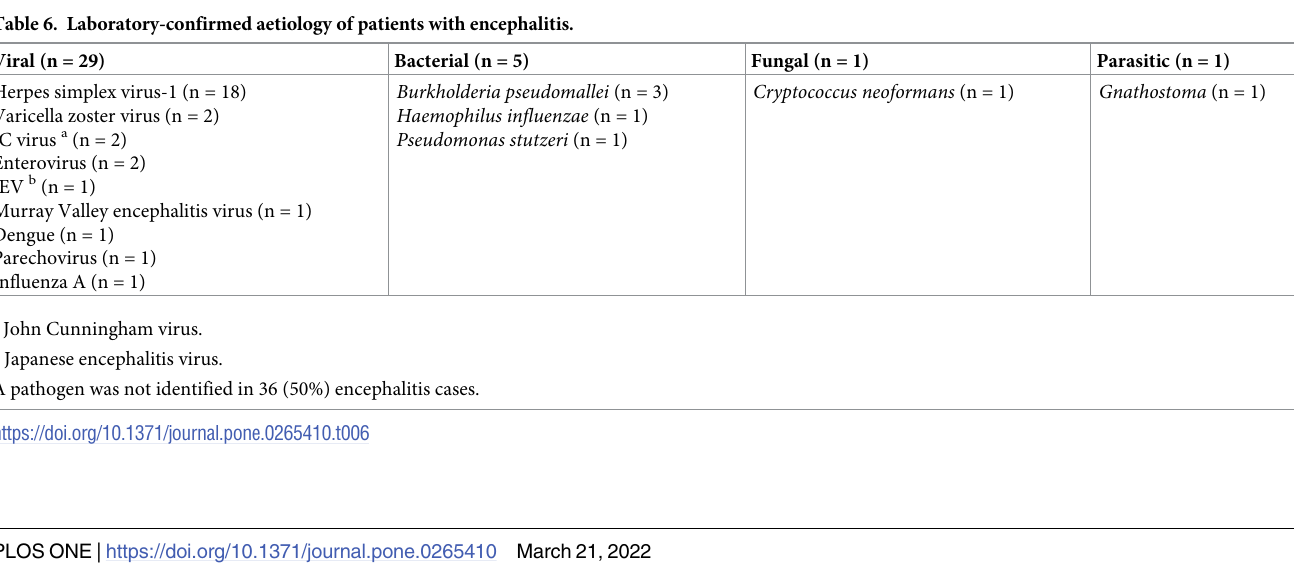
ing one case of JEV imported from PNG in 2004, one case of Murray Valley encephalitis imported from PNG in 2012 and a single case of dengue. The case of dengue encephalitis was diagnosed in a local FNQ resident with no travel history during the last significant outbreak in Cairns in 2009. A case of cerebral gnathostomiasis was identified in a returning traveler from Thailand in 2019. There were 36 cases in which a pathogen was not identified; flavivirus serol- ogy was performed—and was negative—in 12 (33%) of these cases, 6 (17%) of whom also had negative PCR tests for Kunjin and Murray Valley Encephalitis. In addition to the 72 cases of encephalitis, there were 31 cases of immune-mediated encephalitis cases during the study